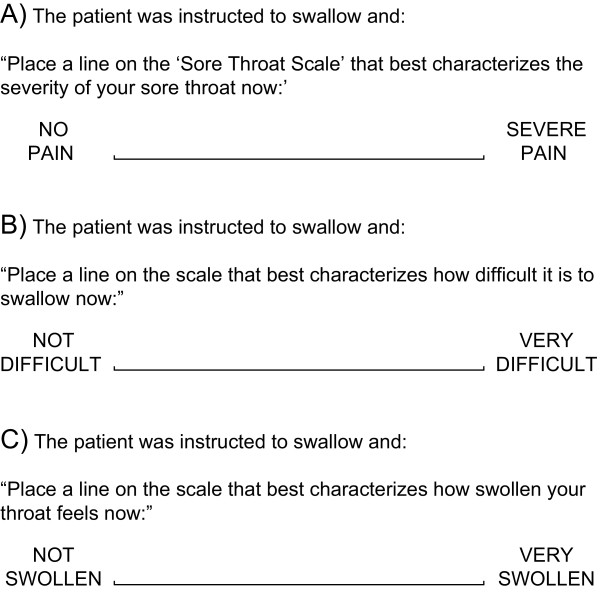
Visual analog scales to assess patient-reported outcomes. The 100-mm visual analog scales used were A) the Sore Throat Pain Intensity Scale (STPIS) to assess sore throat pain, B) the Difficulty Swallowing Scale (DSS) to assess difficulty swallowing, and C) the Swollen Throat Scale (SwoTS) to assess the sensation of a swollen throat.